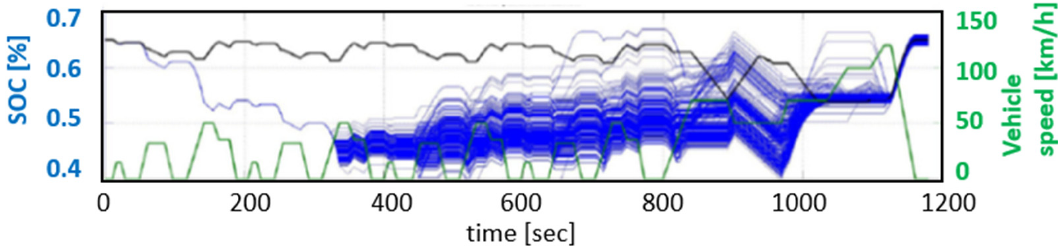
Figure 5. Energy balance analysis for each component in a serial HEV simulation (all energies in kWh).